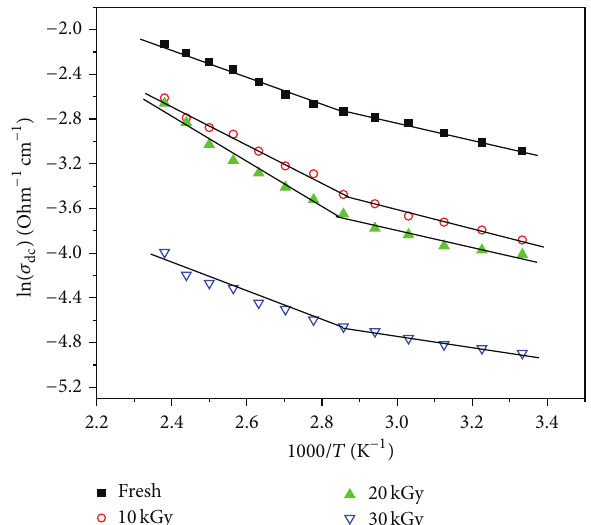
Figure 1: Temperature dependence of the dc conductivity, 𝜎 the investigated CdS thin film before and after 𝛾 -irradiation with different doses.